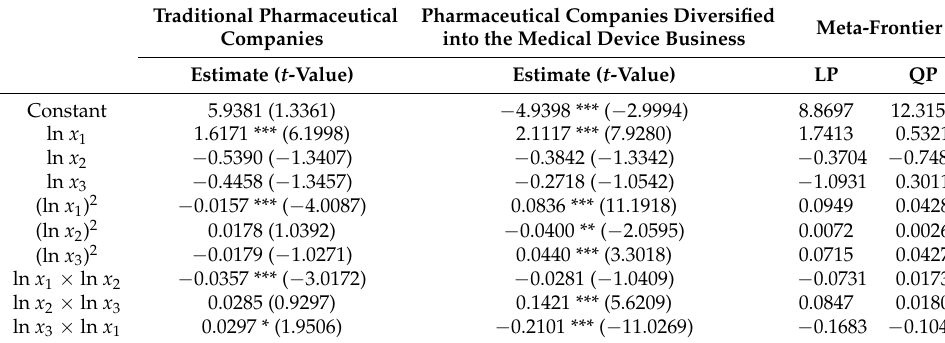
Table 2. Estimation results of group and meta-frontier production functions.